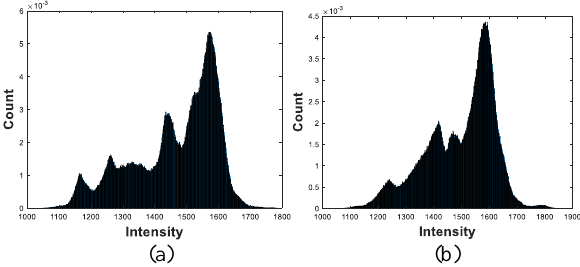
Figure 9. Histogram of intensity distribution of wall 1: (a) Original intensity; (b) corrected intensity;